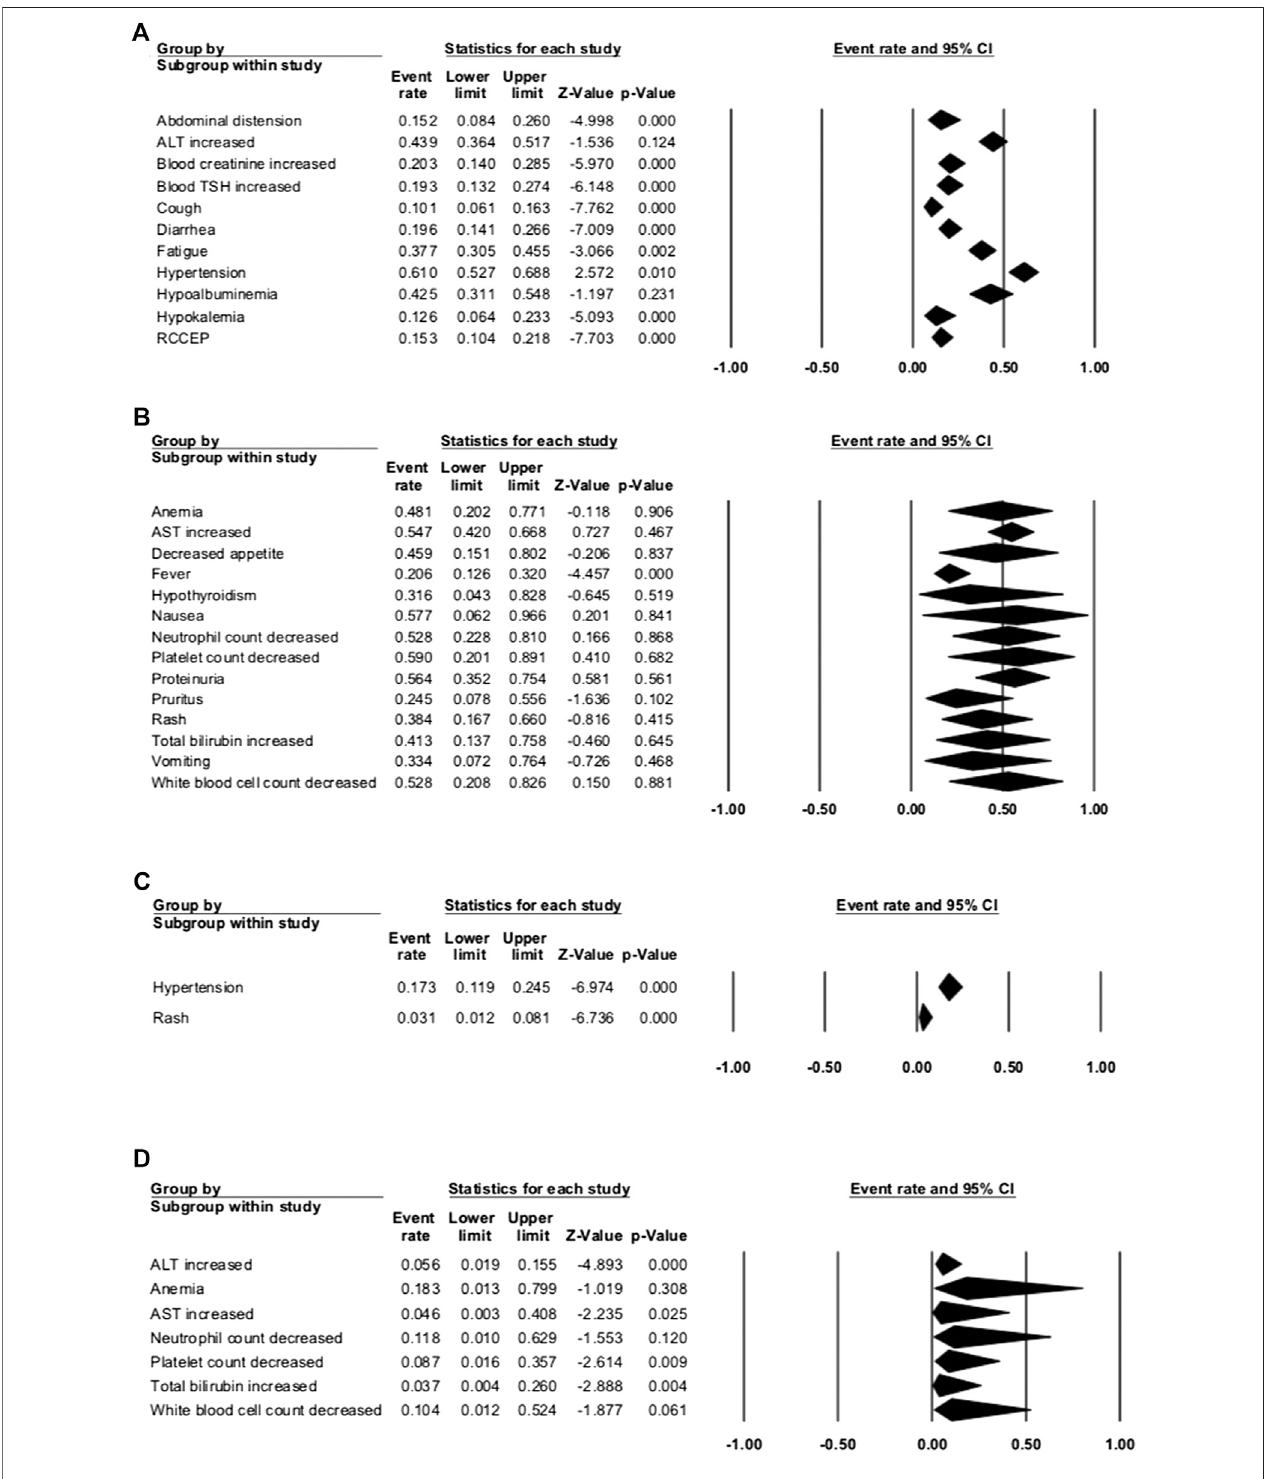
FIGURE3| Adverseevents(AEs)ofcombinationtherapy. (A) The fi xedmodelofall-gradeAEs; (B )therandommodelofall-gradeAEs; (C) the fi xedmodelofgrade ≥ 3 AEs; and (D) the random model of grade ≥ 3 AEs.